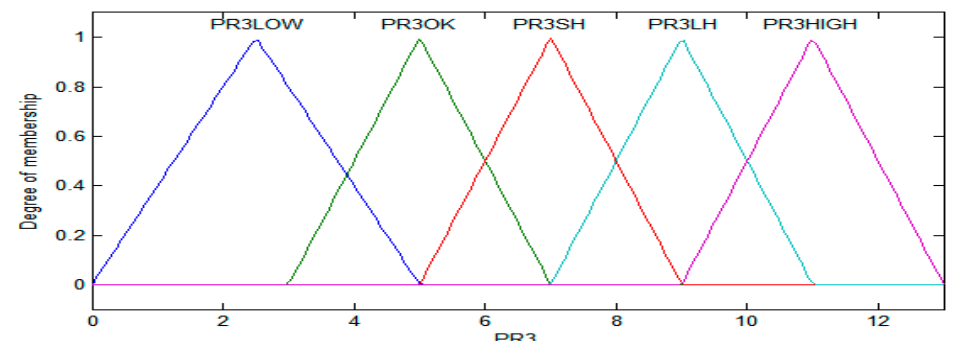
Figure 13. Air quality fuzzy controller inputs and outputs relationship. Energies 2020 , 13 , x FOR PEER REVIEW